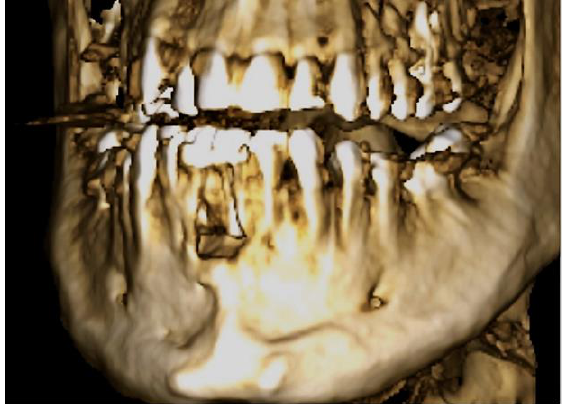
Figure 7. The CBCT reconstruction shows periapical healing, new bone formation, and closure of the lingual defect at the lower incisors’ region 11 months postoperatively. One year after surgery, teeth 32 to 42 were restored with lithium disilicate crowns (E-Max, Ivoclar, Schaan, Liechtenstein) (Figure 8).